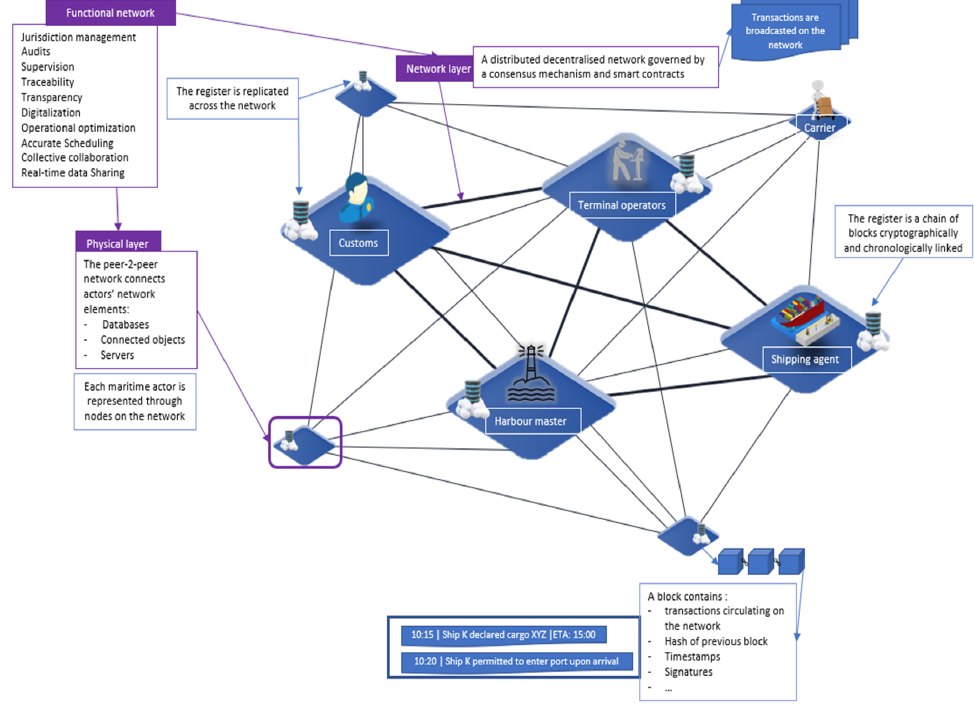
Figure 5. A conceptual blockchain-based maritime ecosystem elaborated by the